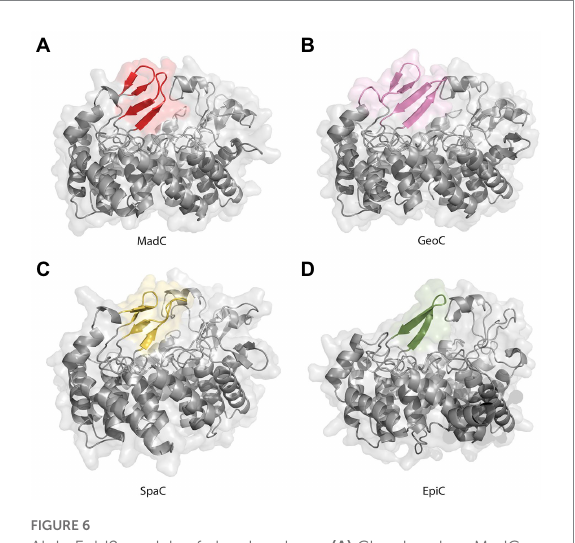
FIGURE 5 Comparison of structures of class I cyclases and a cyclization domain. (A) The AlphaFold2-model of the class I cyclase MadC. (B) The crystal structure of MadC was solved to a resolution of 1.7 Å. (PDB:8BYK). (C) The crystal structure of the class I cyclase NisC from the nisin system (PDB: 2G02). (D) The crystal structure of the cyclase domain of the class II modification enzyme CylM (PDB: 5DZT).